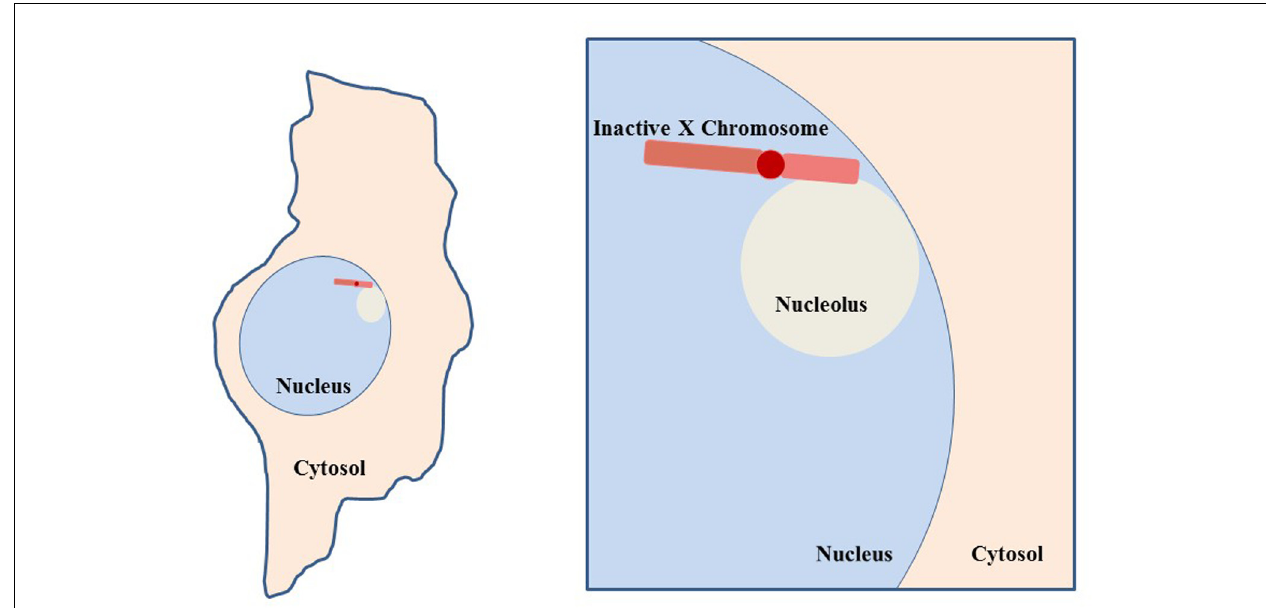
FIGURE 9 | Co-localization of inactive X chromosome with the nucleolus. Depiction of a typical cell, such as a fibroblast, with the nucleolus and Xi in close proximity.This association suggests involvement of the nucleolar